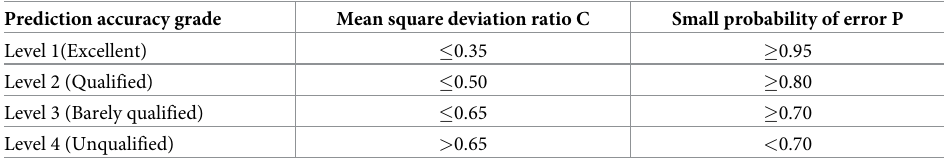
Table 1. The accuracy of gray GM (1,1)